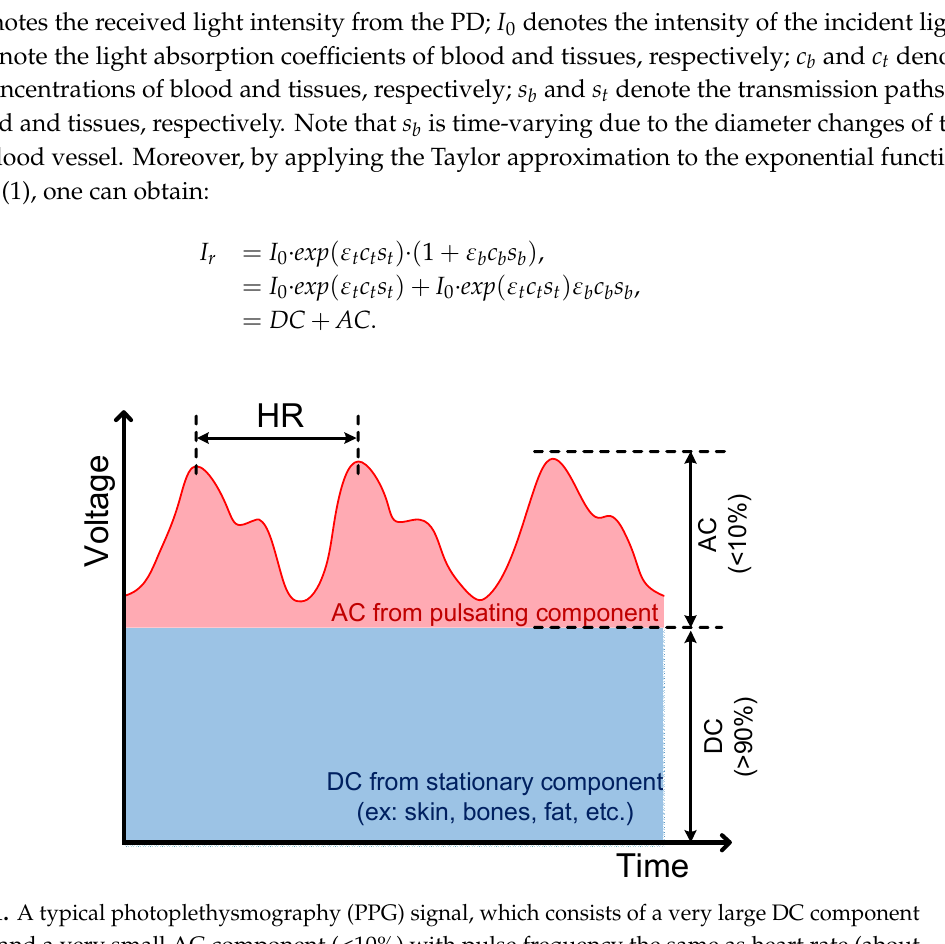
Figure 1. A typical photoplethysmography (PPG) signal, which consists of a very large DC component ( > 90%) and a very small AC component ( < 10%) with pulse frequency the same as heart rate (>90%) and a very small AC component (<10%) with pulse frequency the same as heart rate (about